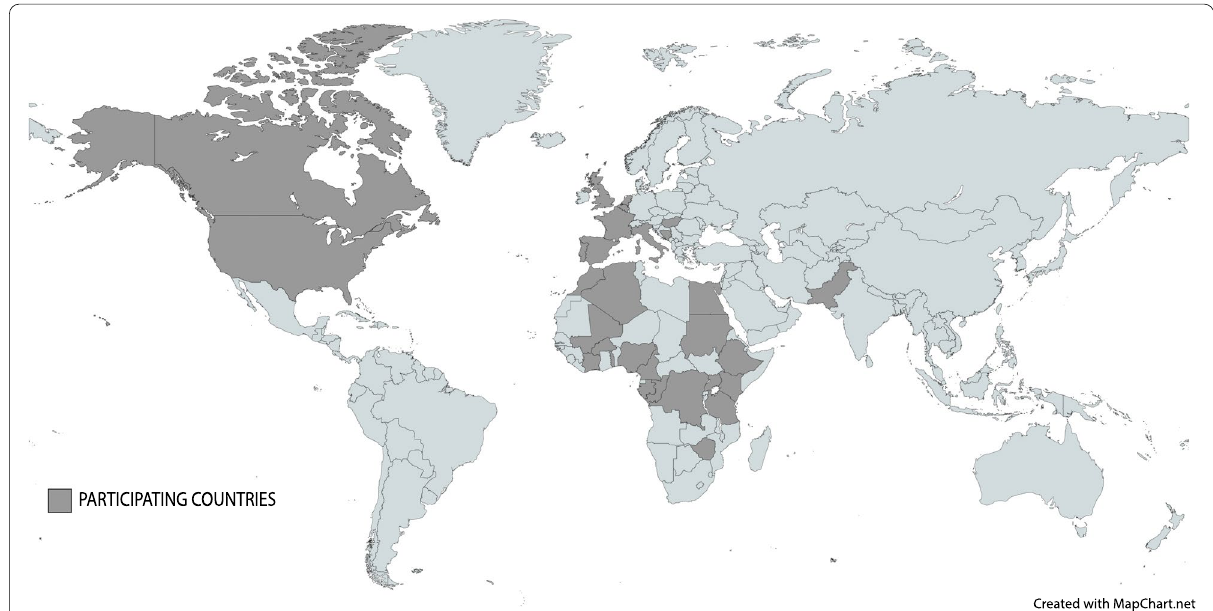
Fig. 1 Map of countries participating in the webinar